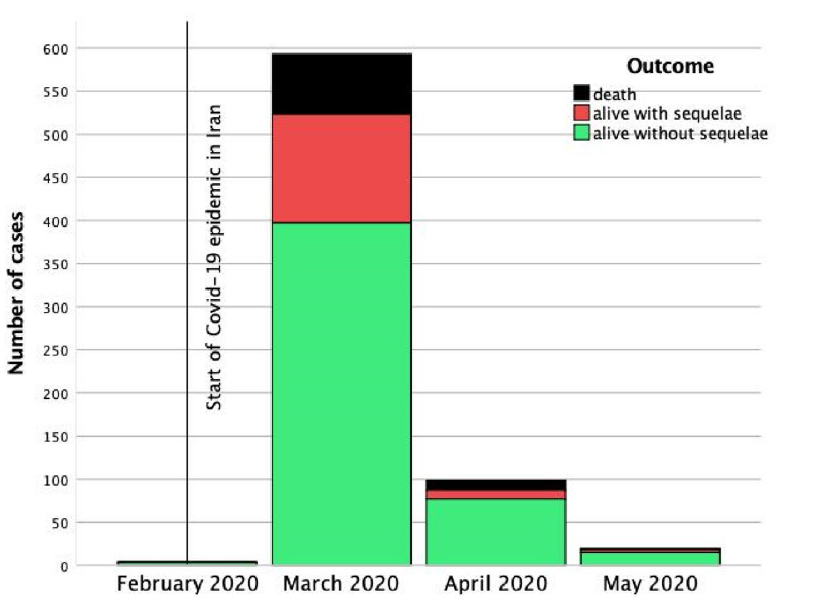
Figure 1. Number of alive (left) and dead (right) patients referred to 11 out of 31 Iranian provinces. Data visualizations were performed using Tableau Desktop, version 2020.1, an interactive data visualization software. (Tableau Software. Seattle, WA; Available through: https:// www. table au. com/).